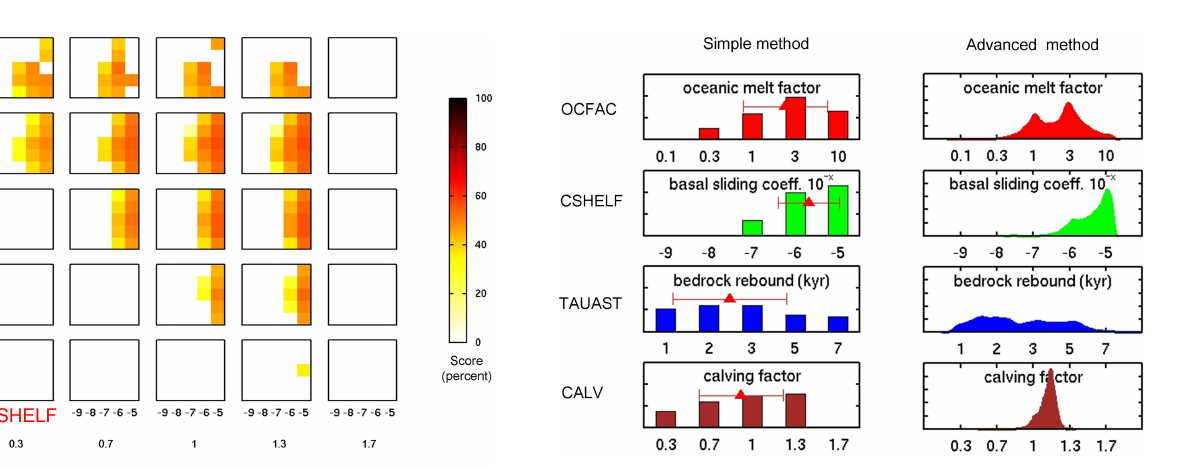
Figure 2. Aggregate scores for the complete large ensemble suite of runs (625 runs, 4 model parameters, 5 values each, Sect. 2.2), used in the simple method with score-weighted averaging. The score val- ues range from 0 (white, no skill) to 100 (dark red, perfect fit). The figure is organized to show the scores in the 4-D space of parame- ter variations. The four parameters are CSHELF = basal sliding co- efficient in modern oceanic areas (exponent x , 10 − x ma − 1 Pa − 2 ) , TAUAST = e -folding time of bedrock-elevation isostatic relaxation (kyr), OCFAC = oceanic-melt-rate coefficient at the base of float- ing ice shelves (non-dimensional) and CALV = calving-rate factor at the edge of floating ice shelves (non-dimensional). Since each parameter only takes five values, the results are blocky, but effec- tively show the behavior of the score over the full range of plausible parameter values.